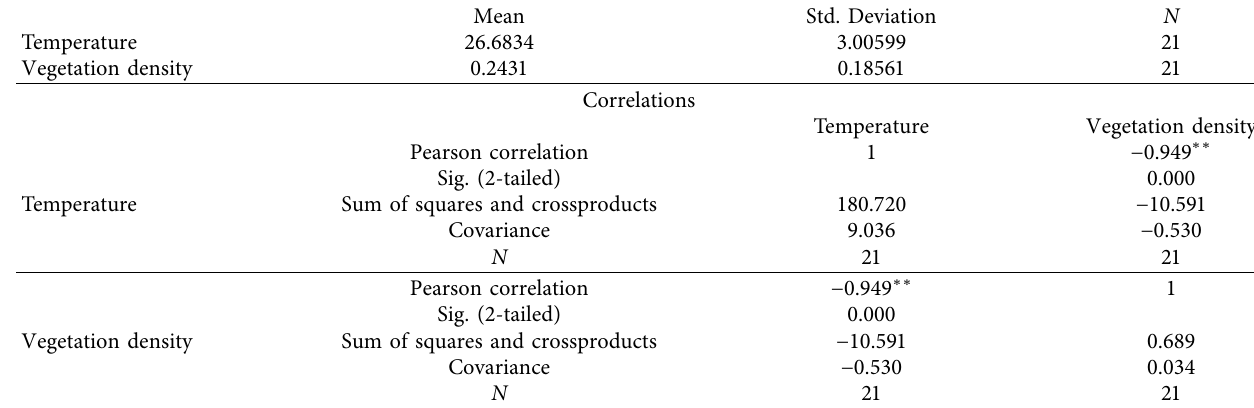
Table 9: Te correlation between surface temperature and vegetation density in Banjarmasin City in